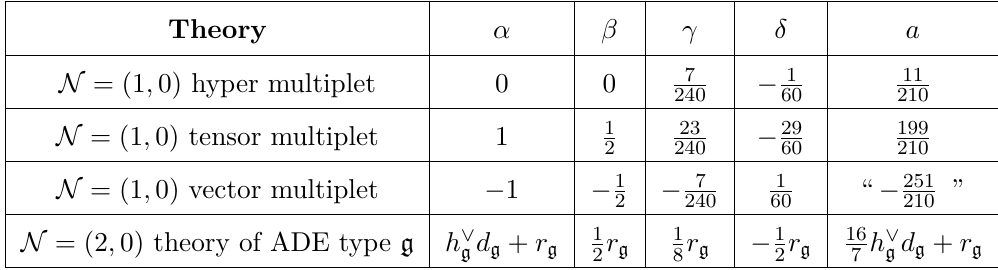
Table 1 . ’t Hooft and a -anomalies for some SUSY theories. The negative entry for the a -anomaly of the N = (1 , 0) vector multiplet should not be taken at face value (hence the double quotes) and is further discussed in the text. The N = (2 , 0) theories are associated with an ADE Lie algebra g , with rank r , dimension d , and dual Coxeter number h ∨ g g g